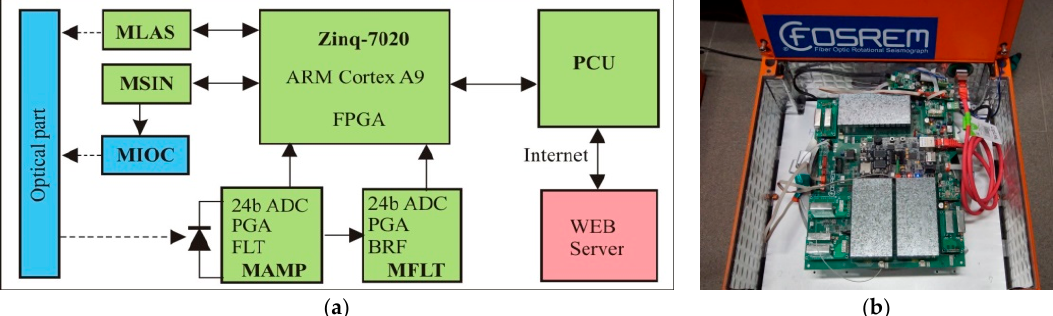
Figure 3. The electronic part of the sensor: ( a ) block diagram, ( b ) technical realization for FOSREM-1.